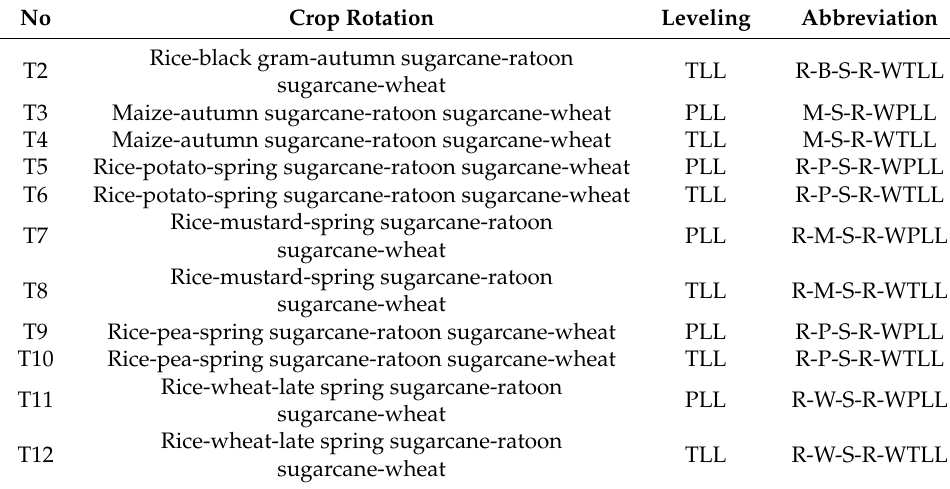
Table 2. Summary of experimental treatments.